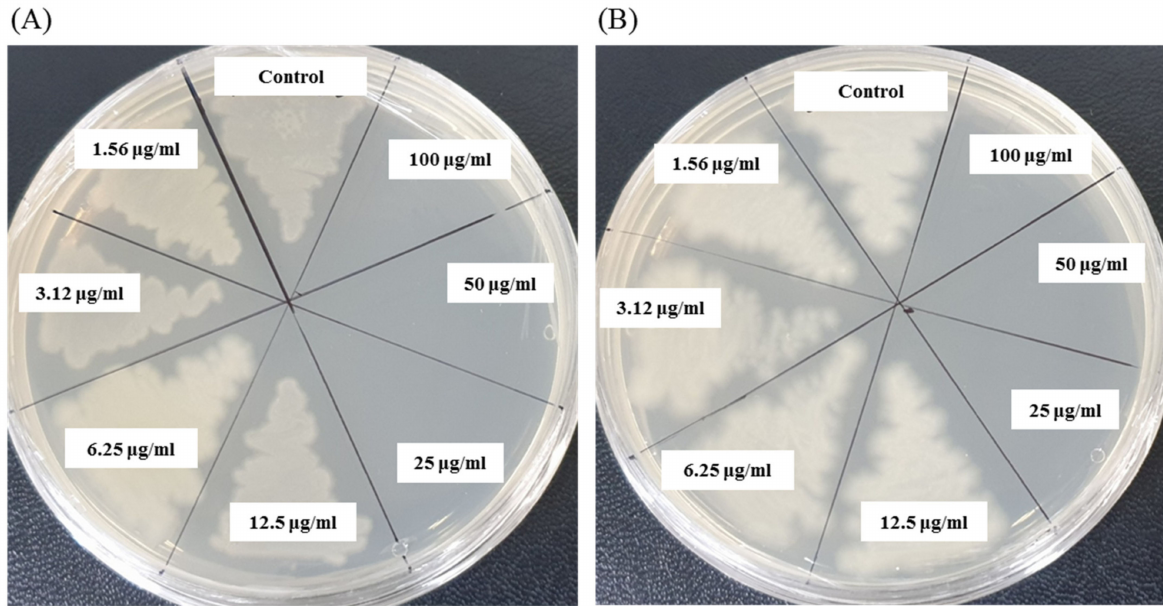
Figure 8. Growth curves of P. aeruginosa ( A ) and B.cereus ( B ) cultured in MHB with different concentrations of P. nicotinovorans MAHUQ-43-mediated synthesized AgNPs to determine MIC.